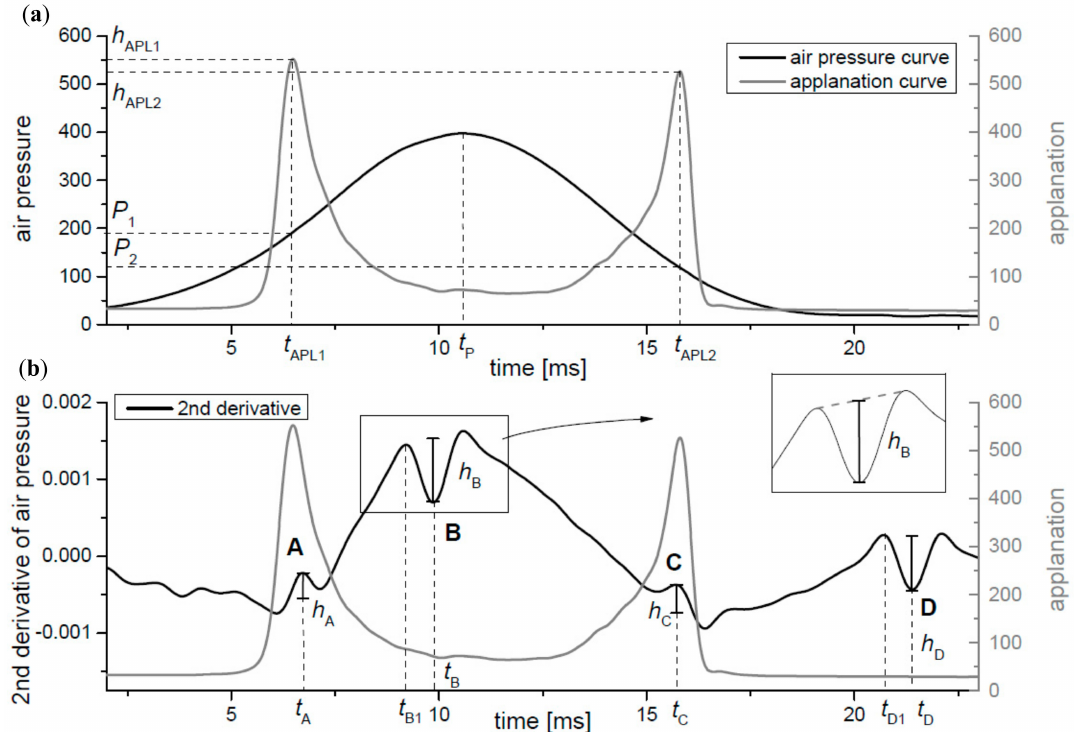
Figure 1. The applanation and the air pressure curves ( a ) and the second derivative of the air pressure curve ( b ) with parameters estimated from the curve. See text for model notation details and description of